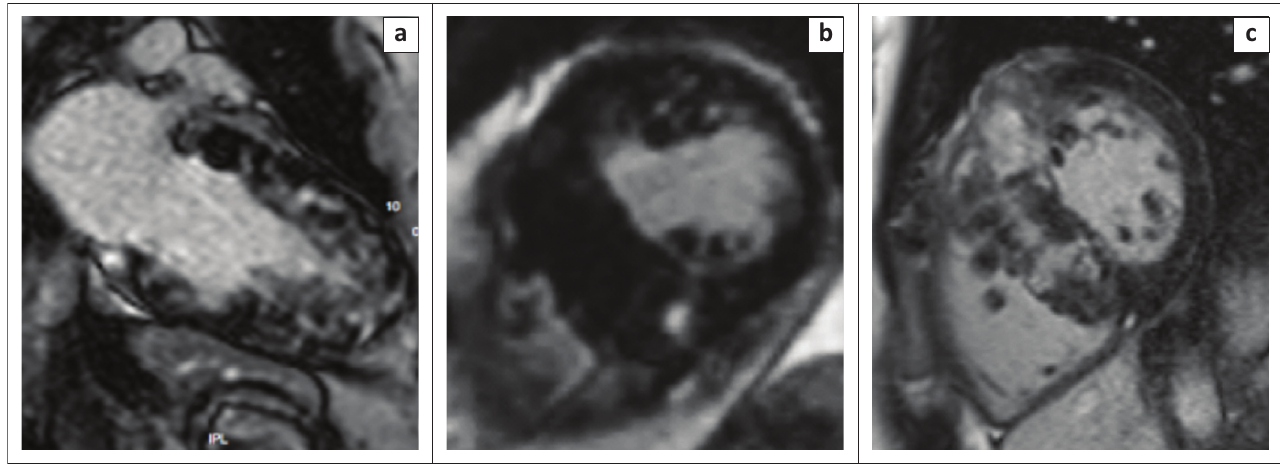
FIGURE 6: (a) An alcohol ablation that is acute (microvascular obstruction at the core with a limited scar in the moderator band which may also have been an ‘off-target’ consequence. (b) A myectomy (ciné still in diastole) with Alfieri stitch.